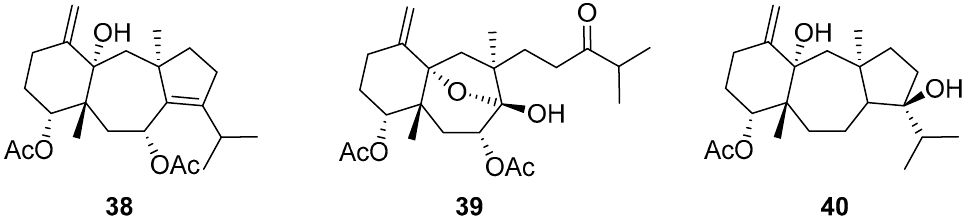
Figure 16. Structures of marine dolastanes ( 38 and 40 ) and secodolastane diterpene ( 39 ) derived from Canistrocarpus cervicornis .